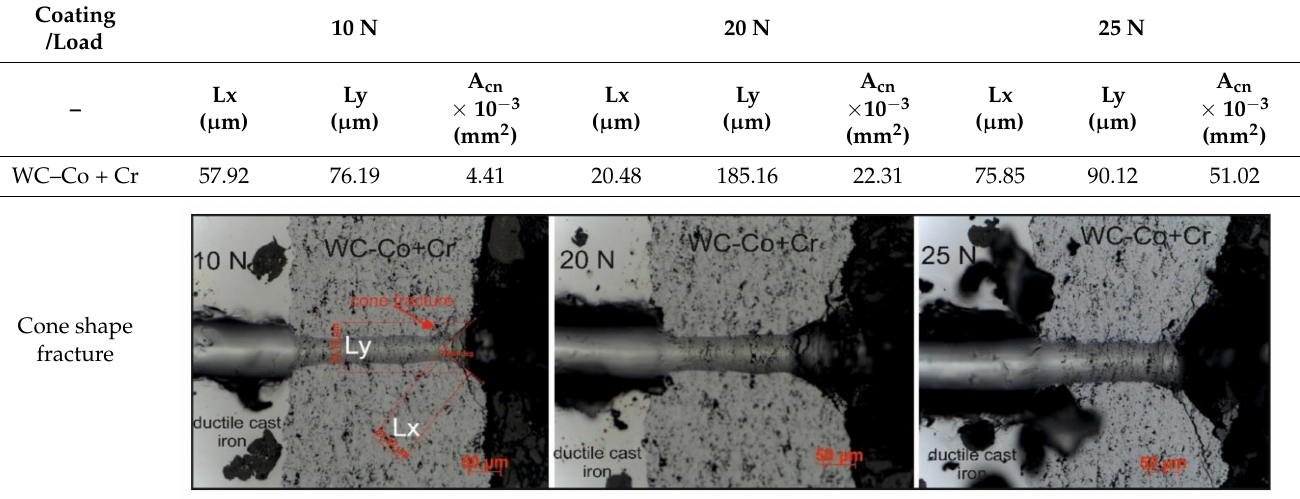
Table 5. Averaged scratch bond test results of WC – Co+Cr